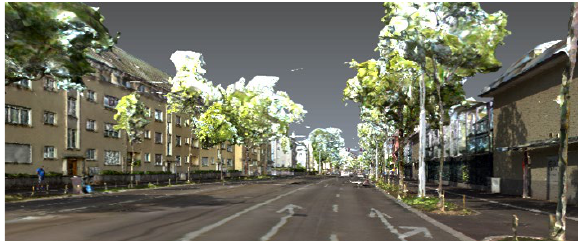
Figure 7 . Reconstructed 3D scene using backpack and vehicle data in ContextCapture